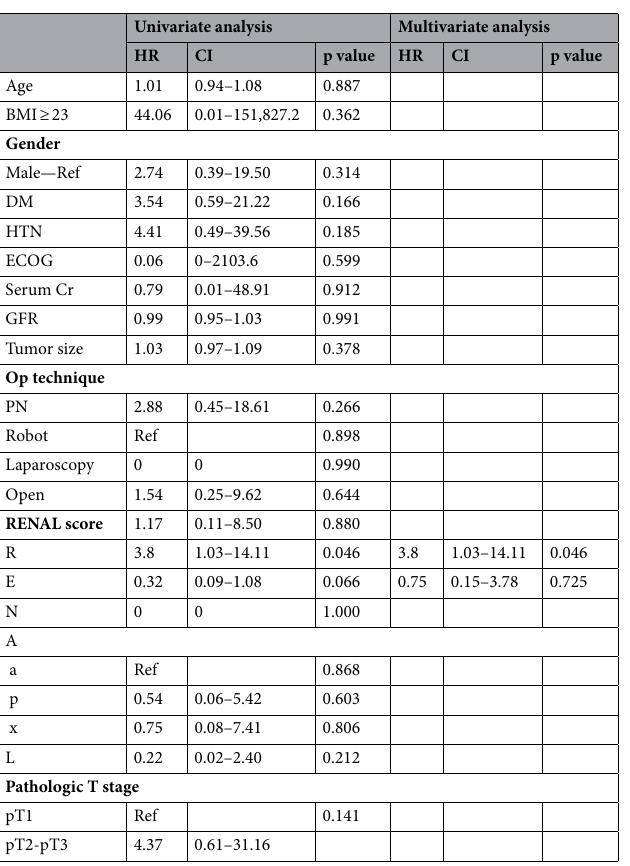
Table 3. Univariate and multivariate analysis for overall survival after nephrectomy. BMI body mass index, DM diabetes mellitus, HTN hypertension, ECOG Eastern cooperative oncology group performance status,